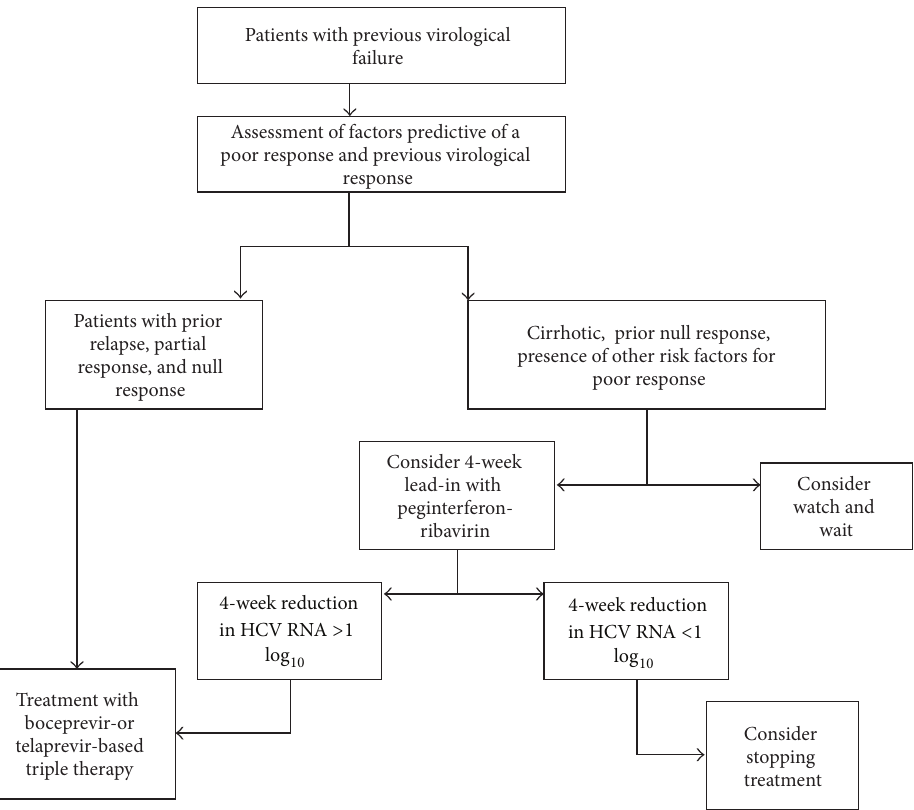
Figure 4: Proposed algorithm for the use of protease inhibitors in HCV genotype 1 infected patients who have had previous virological failure on treatment. Pretreatment assessment should include careful consideration of lifestyle factors, comorbid conditions, potential drug interactions, assessment for the presence of cirrhosis, and the presence of factors predictive of a poor response to therapy. Identification of the degree of previous response should be attempted. If this information is not available, patients should be considered as prior null responders to maximize cure rates. In cirrhotic prior null responders, the decision to watch and wait for novel therapies or to use a 4-week lead-in with peginterferon and ribavirin to identify patients more likely to achieve an SVR should only be taken following careful and balanced discussion with the patient. Excerpted from Ramachandrean et al.